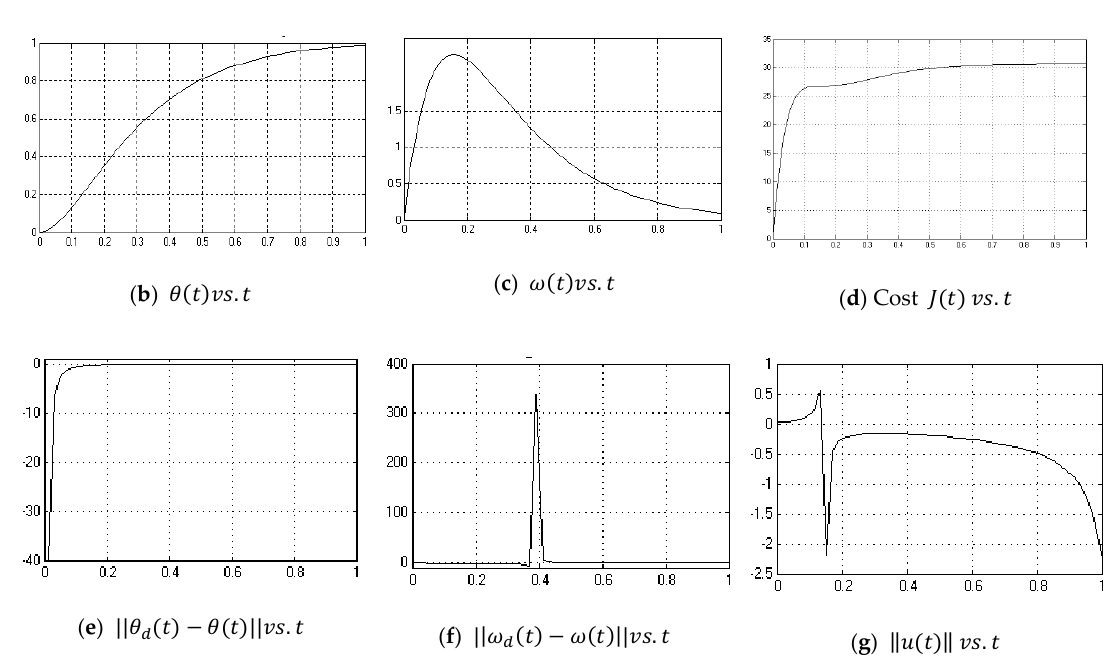
Figure A3. Proportional-derivative (PD) controller ( K w = − 13.3, K q = 40) simulation model.